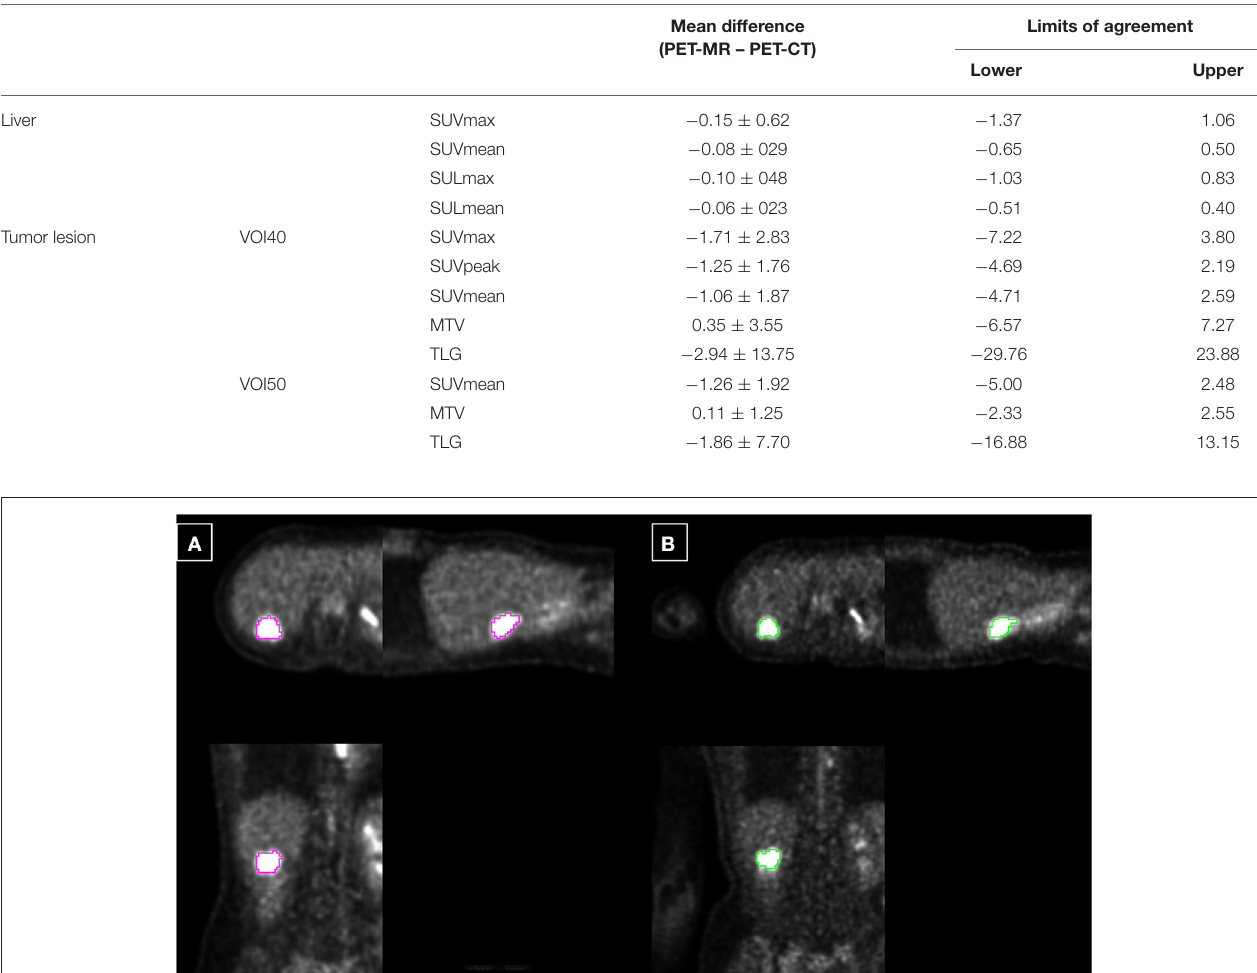
TABLE 4 | The result of Bland-Altman analysis of SUV measurements between PET/CT and PET/MR.